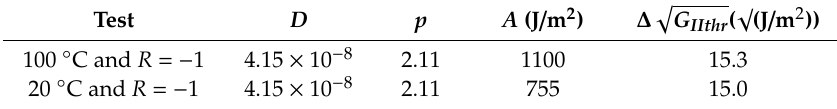
Table 2. Values of the parameters used in [60] to represent Mode II crack growth in